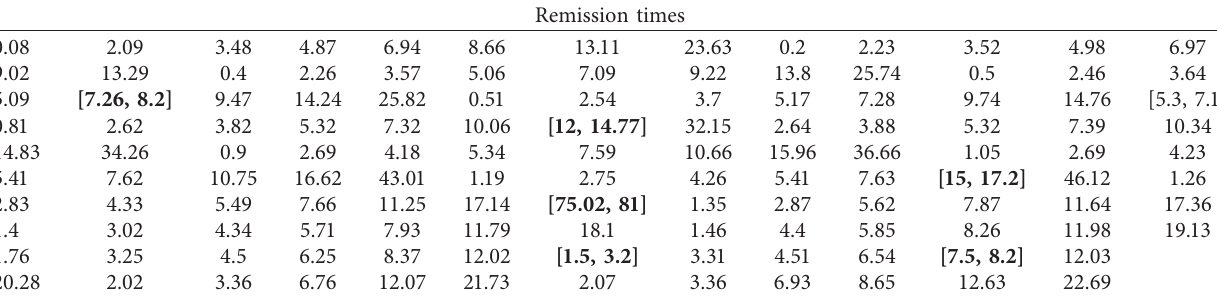
Bold values mean imprecise/indeterminate values. Table 4: Neutrosophic statistics of remission times data by using the proposed model. Descriptive